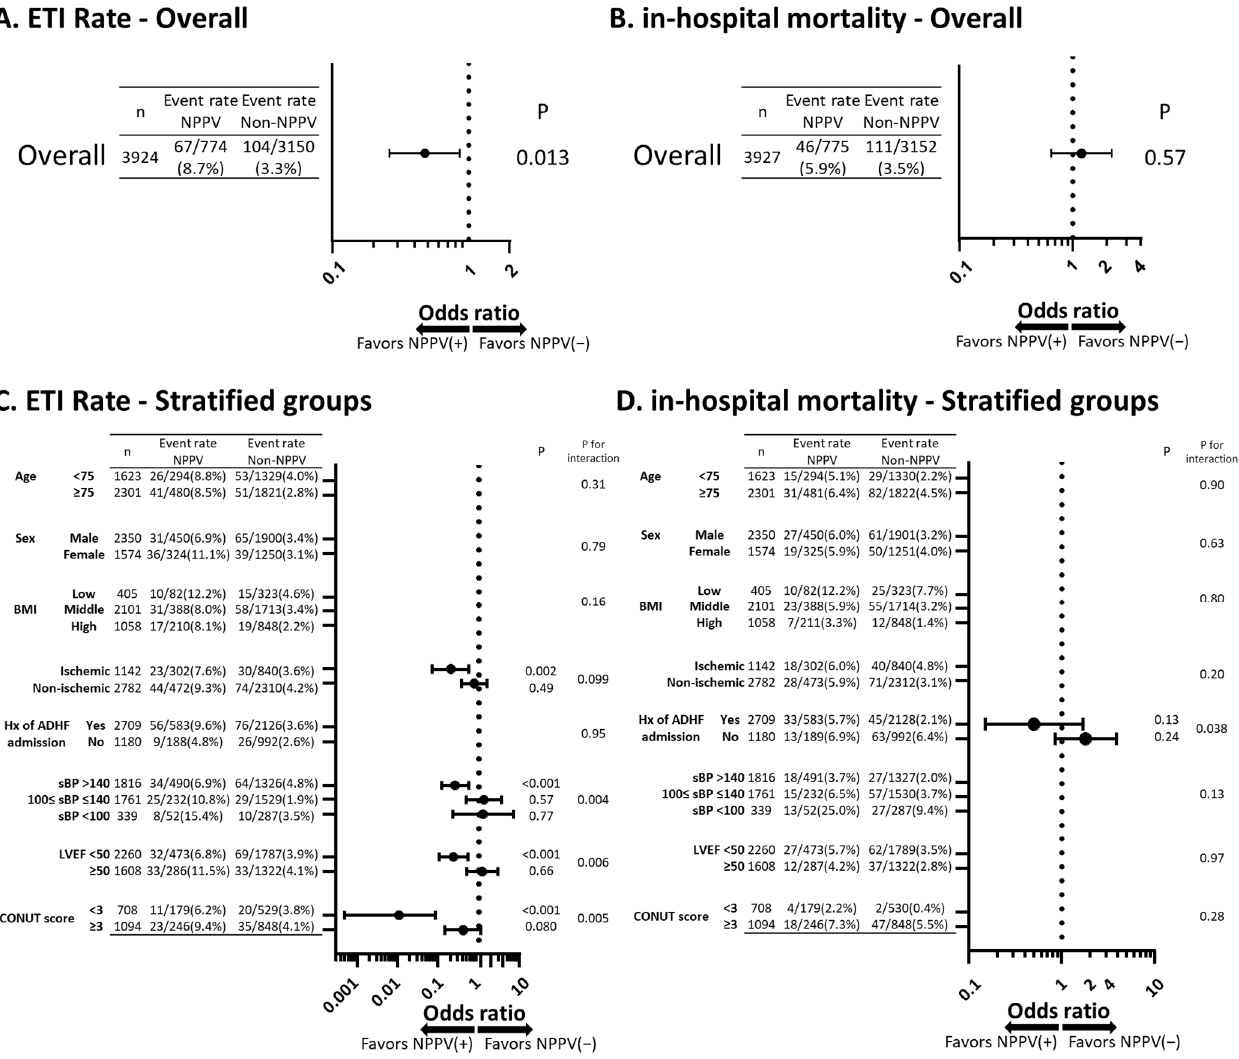
Figure 3. In-hospital outcomes with adjustment for propensity score in the pre-matched overall cohort and the stratified groups. ( A ) ETI rate for overall population, ( B ) in-hospital mortality for overall population, ( C ) ETI rate for stratified groups, and ( D ) in-hospital death for stratified groups are depicted. ETI, endotracheal intubation; NPPV, non-invasive positive pressure ventilation; BMI, body mass index (low BMI: BMI < 18.5, middle BMI: 18.5 ≤ BMI < 25, high BMI: BMI ≥ 25); Hx, history; sBP, systolic blood pressure; LVEF, left ventricular ejection fraction; CONUT, the Controlling Nutritional Status. Table 3. Multiple regression analysis for LOS with adjustment for propensity score in the pre-matched overall cohort and stratified groups.